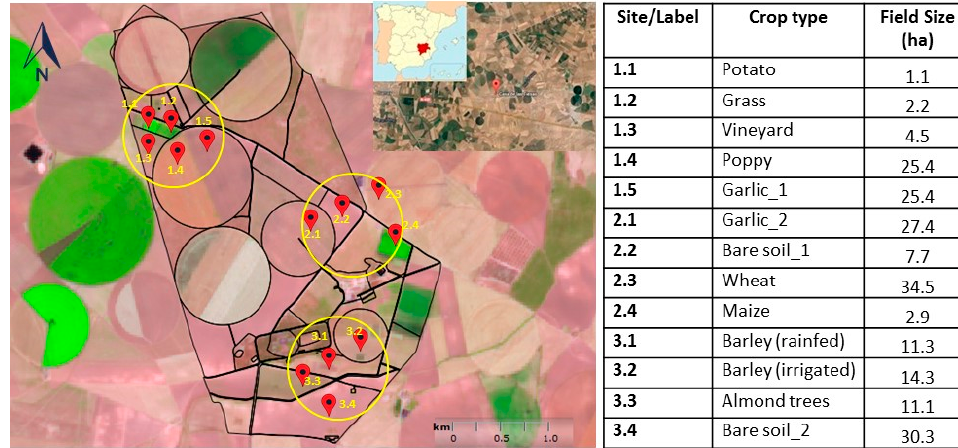
Figure 1. Overview of “Las Tiesas” experimental farm. Measurement sites are located over a S2 false color composition corresponding to date 25 July 2018. Labels for the different study fields are explained in the adjacent Table, together with indication of crop type and field size.